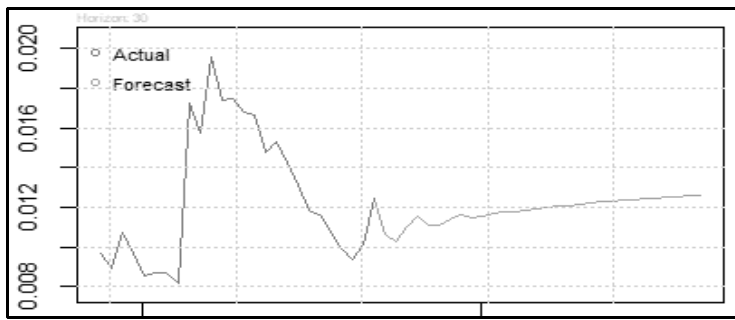
Figure.5. Long-term (60 days) Prediction using GARCH Source: Author’s own